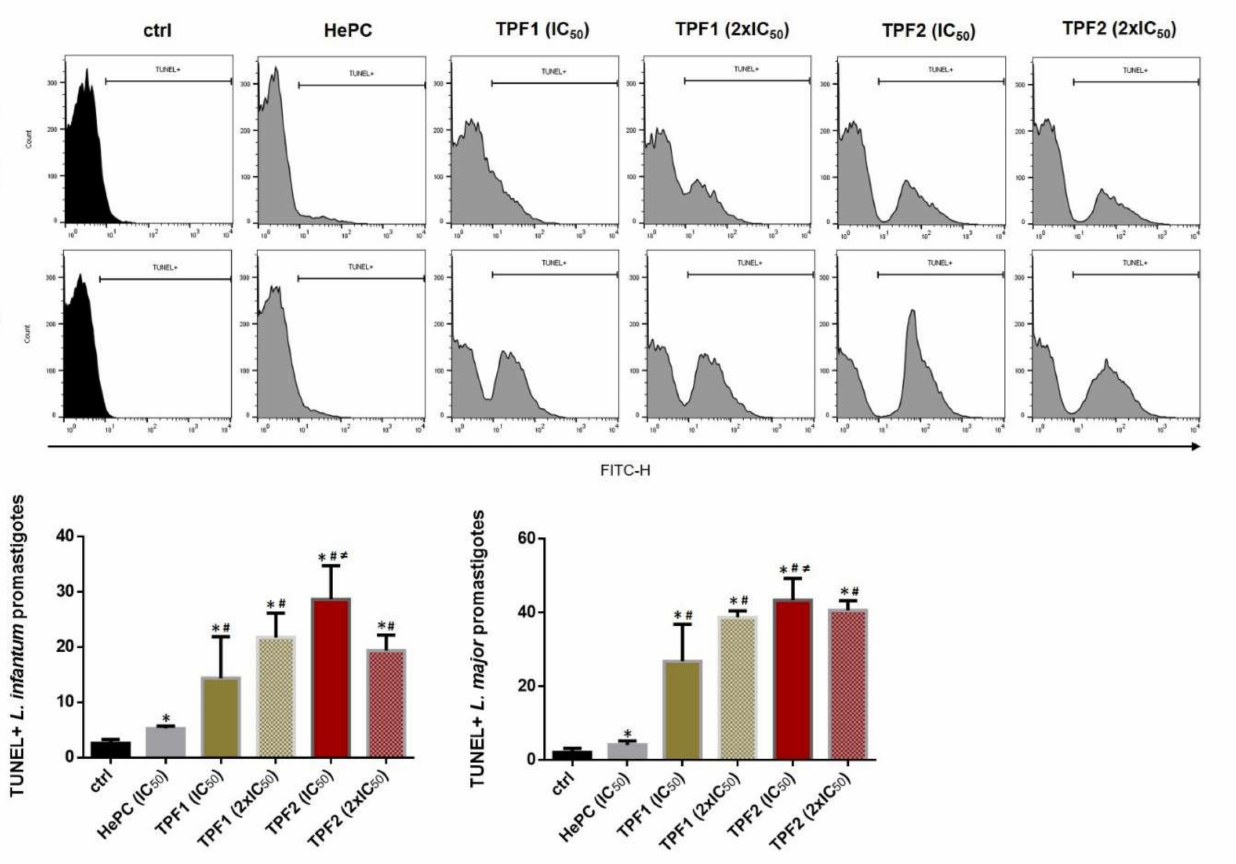
Figure 6. Changes in phosphatidylserine exposure and plasma membrane integrity in TPF1- and TPF2-treated L. infantum and L. major promastigotes. Log-phase L. infantum ( A ) and L. major ( B ) promastigotes were either left untreated (negative control) or were treated with IC 50 and 2 × IC 50 doses of TPF1, TPF2 and HePC (positive control) for 72 h. Parasites were labelled with annexin V-FITC and PI that discriminate between early (annexin V+/PI-) and late (annexin V+/PI+) apoptotic, necrotic (annexin V-/PI+) and live (annexin V-/PI-) parasites. Phosphatidylserine exposure and cell membrane permeability were quantified by flow cytometry and data are presented as flow cytometric dot plots with respective quadrants, representative of one experiment.